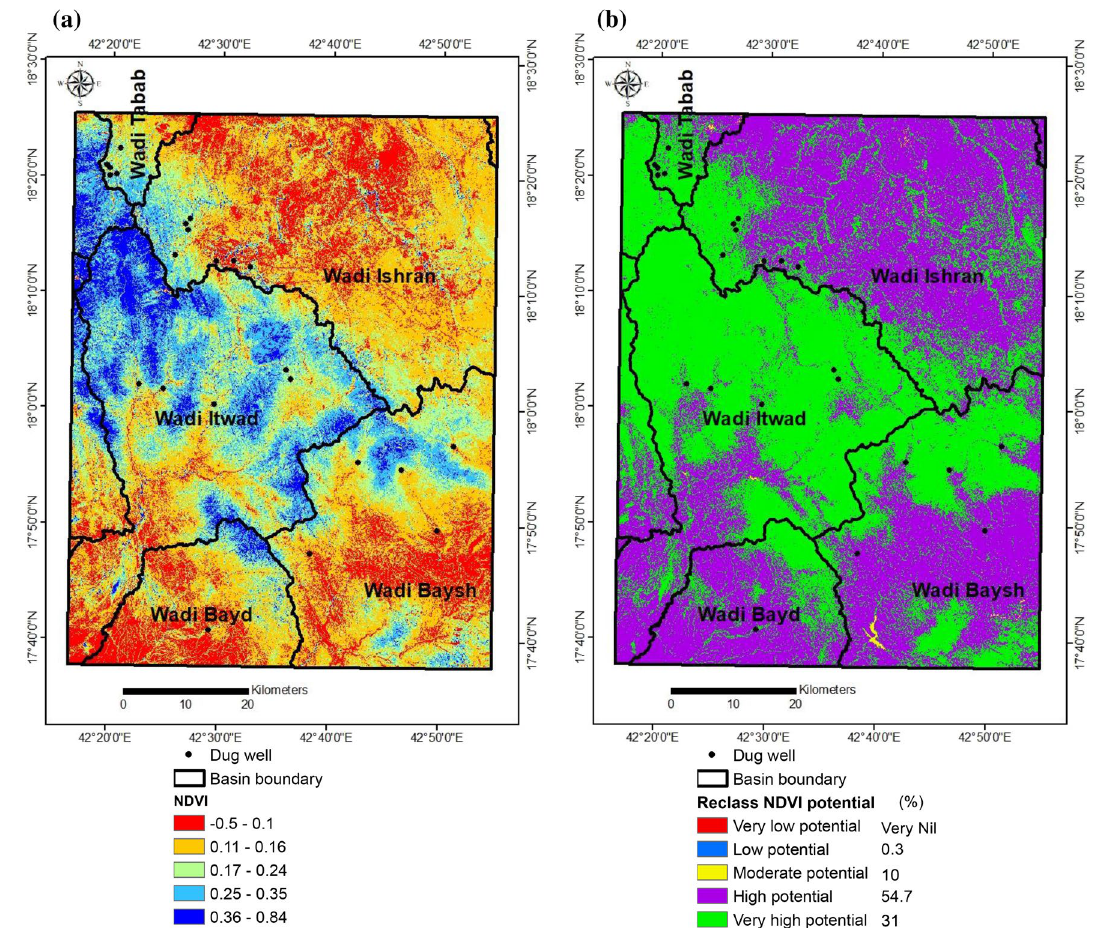
Fig. 10 a NDVI and b Reclassified NDVI of the study